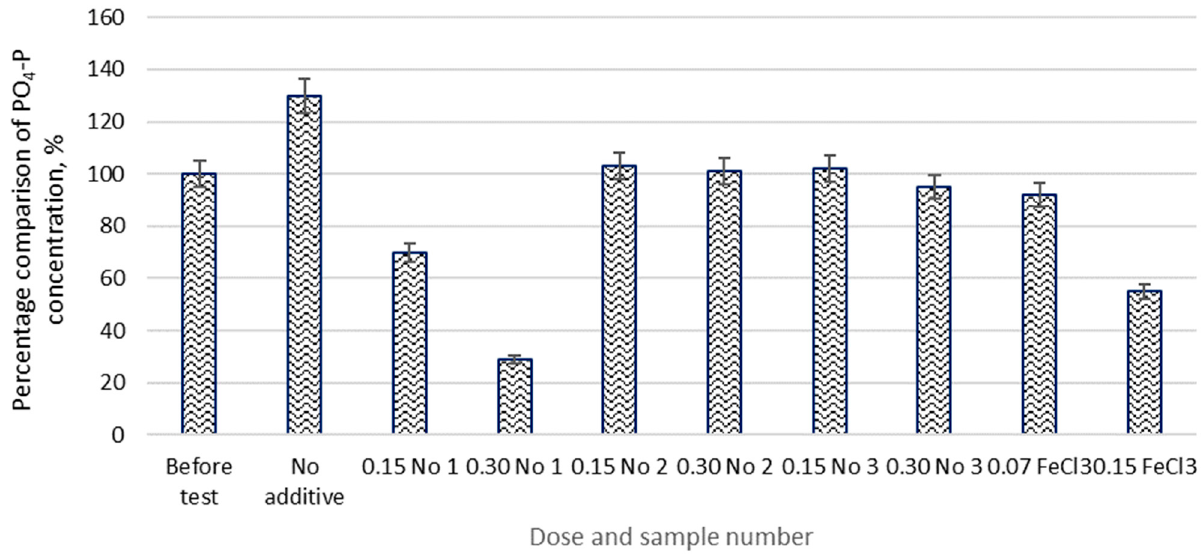
Figure 7. Percentage comparison of phosphate phosphorus concentration in samples. Doses of the additives are indicated in g/g SM/20 d.